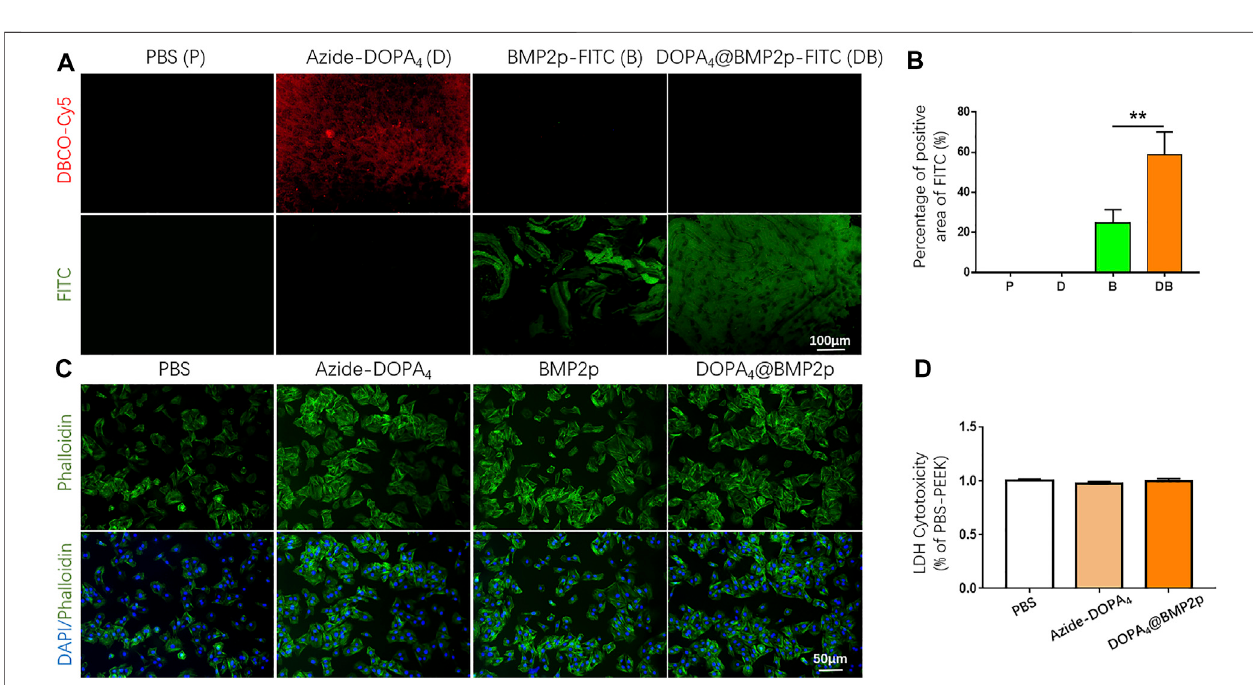
FIGURE 3 | Biocompatibility of different modi fi ed substrates, and bioclickable BMP2p binding on PEEK after Azide-DOPA 4 coating. (A) Fluorescence images of PEEKsubstratestreatedwith fl uorescentdyeslabeledAzide-DOPA 4 andBMP2p-FITC. (B) PercentageofFITCpositiveareasofPEEKafterdifferenttreatmentmethods, (C) Morphologies of adherent rBMSCs after 6 h of culture. The cells were stained with DAPI (nuclei, blue) and Alexa Fluor 488 – conjugated phalloidin (actin fi laments, green). (D) Quanti fi cation of LDH. Abbreviations: P (PBS), D (Azide-DOPA 4 ), B (BMP2p-FITC), and DB (DOPA 4 @BMP2p-FITC).